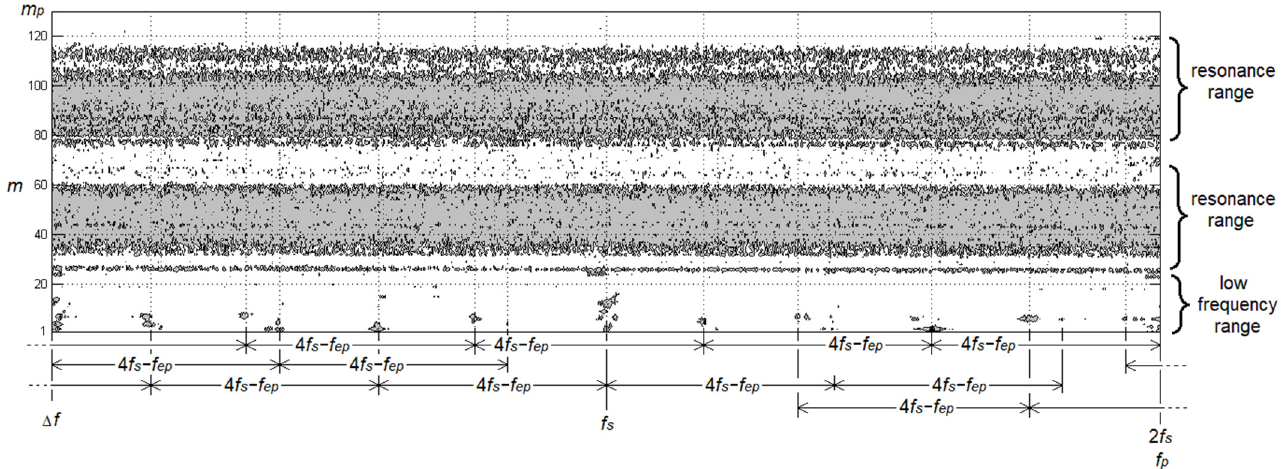
Figure 12. F-F image of the frequency spectrum of the vibration acceleration of the motor’s outer casing with the bearing slackness ( f P = 2 f s ).